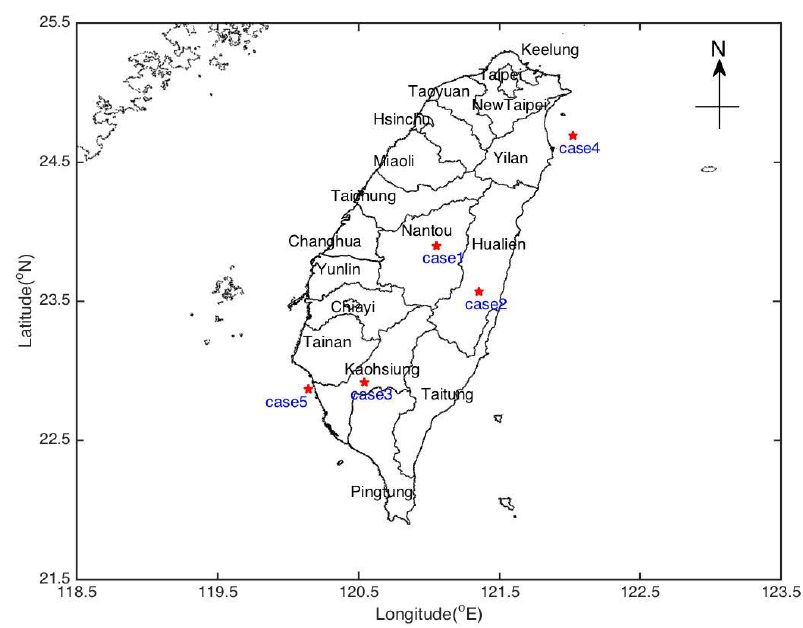
Figure 8. The red pentagram symbol denotes the locations of the five earthquakes in the Taiwan area.